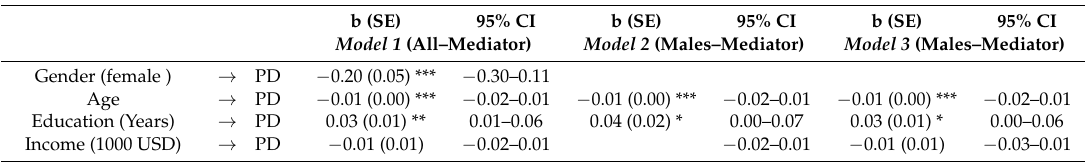
Table 3. Summary of path coefficients for the effects of household income and educational attainment on perceived discrimination via racial composition of workplace in the pooled sample.